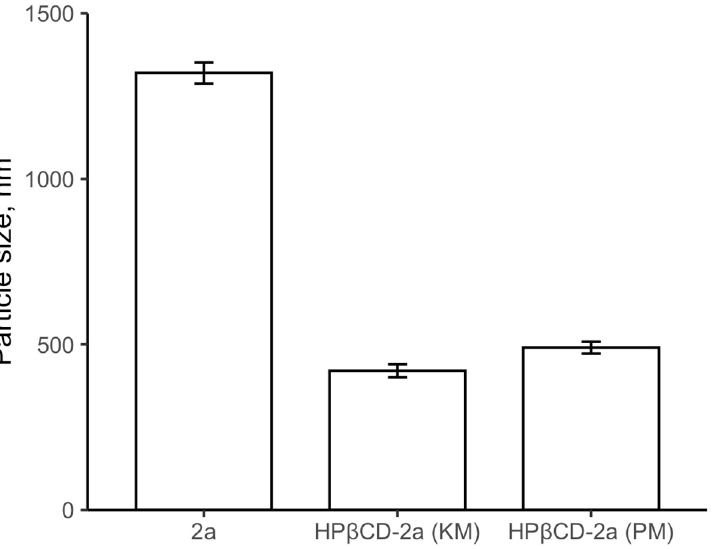
Figure 5. Size of particles in supernatants of 2a and HP β CD- 2a complex prepared by KM and PM. C 2a =1 mg/mL, C HP β CD = 12 mg/mL, pH 7.4.